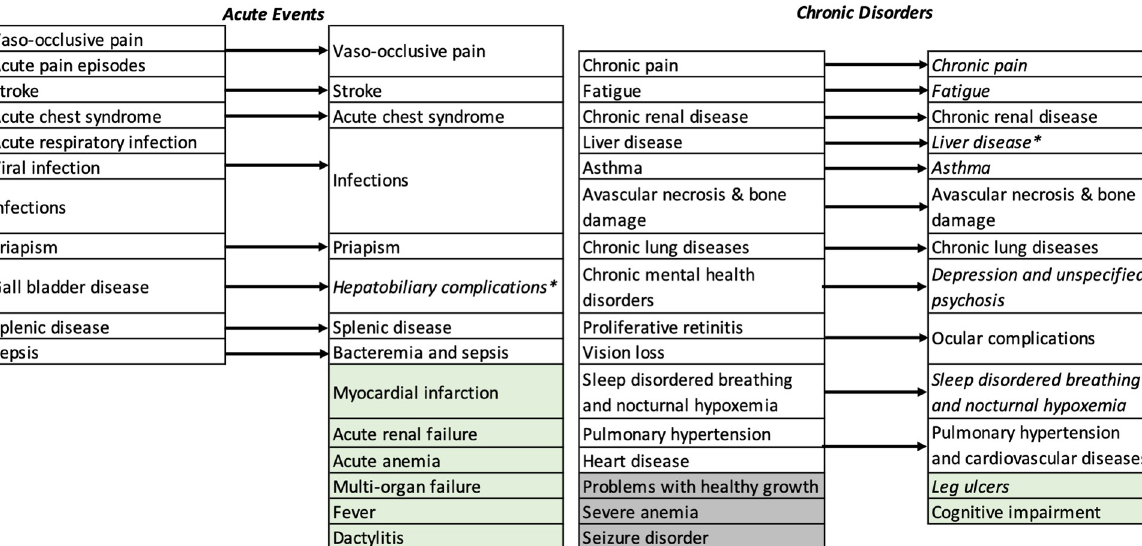
PLOS ONE | https://doi.org/10.1371/journal.pone.0267448 April 28,